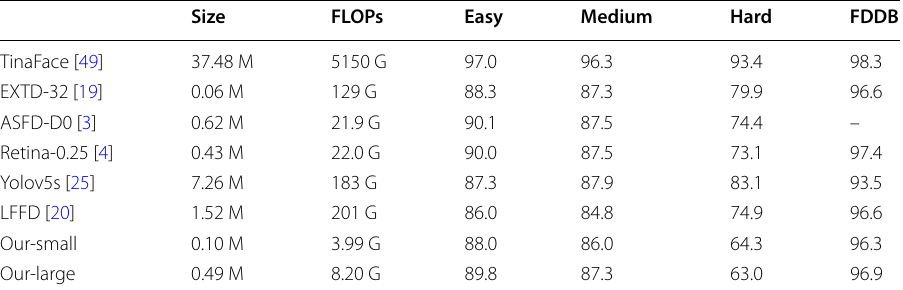
Table 2 The comparison with other detectors in model size, computation amount, and performances (AP%)